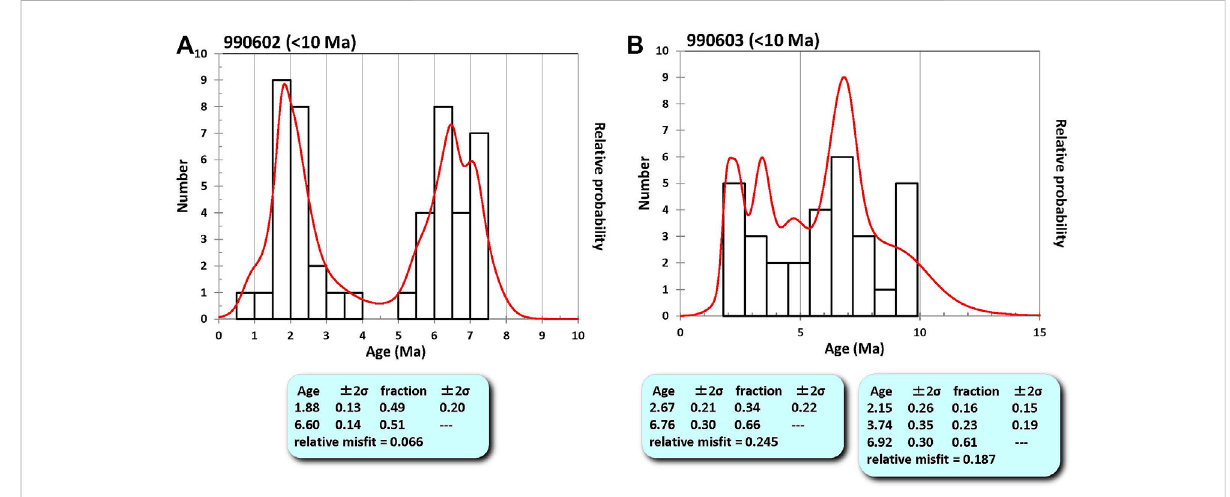
FIGURE 7 238 U- 206 Pb age distributions (histogram, probability density plot) for zircons younger than 10 Ma. (A) sample 990602, (B) sample 990603. Lower panels show the result of age peak deconvolution using Isoplot 4.15 (Ludwig,